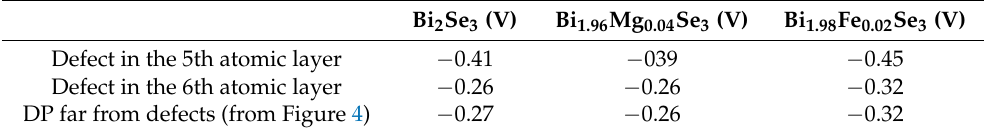
Figure 5. Normalized STS spectra measured at room temperature in positions far from the defects (black), at the 5th atomic layer defect (red) and at the 6th atomic layer defect (green) on ( a ) Bi 2 Se 3 , ( b ) Bi 1.96 Mg 0.04 Se 3 , ( c ) Bi 1.98 Fe 0.02 Se 3 , respectively. Table 1. The positions of the maxima of the additional electronic states were observed at specific defects using the STS